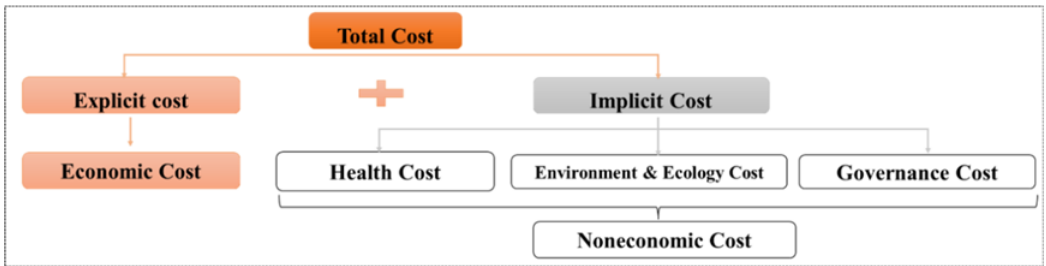
Figure 2. Deconstruction of coal reduction